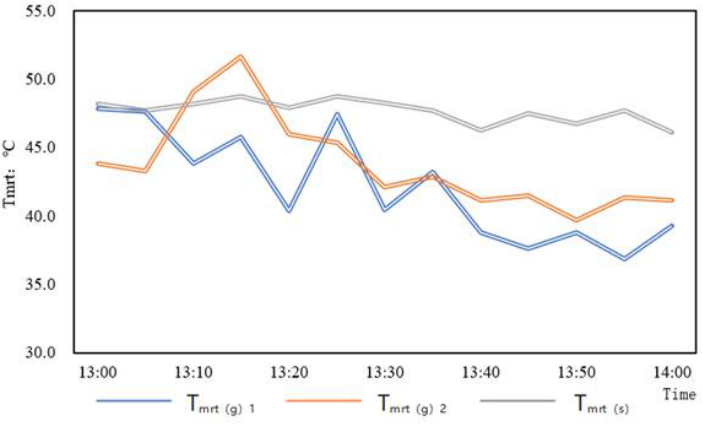
Figure 10. The results of Tmrt (s), Tmrt (g)1, and Tmrt (g)2.